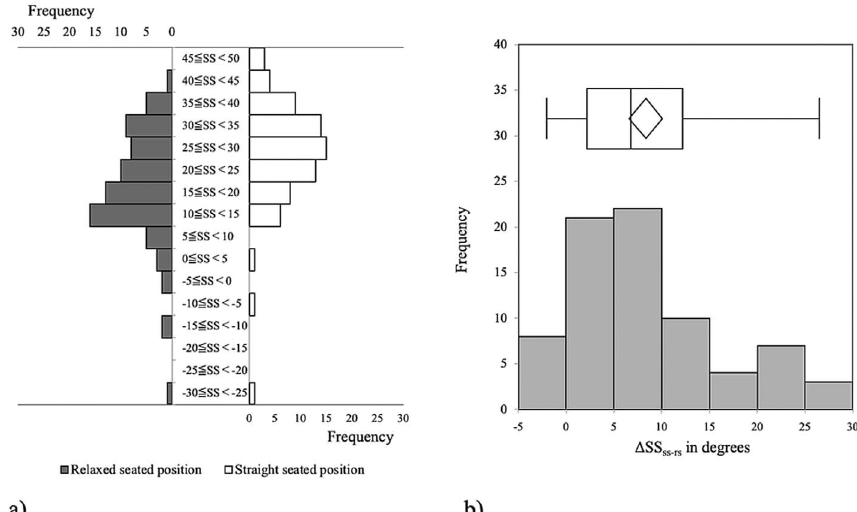
Figure 3. The distributions of sacral slope (SS) in each seated position (a) and the change in SS from the straight to the relaxed seated position ( D SS) (b) are shown. D SS is not normally distributed. The range, median, and mean values are (cid:1) 2.0 (cid:1) to 26.5 (cid:1) , 6.8 (cid:1) , and 8.3 (cid:1) ,